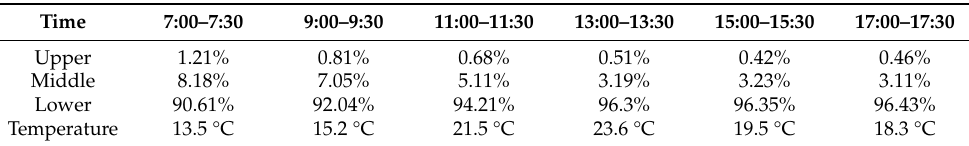
Table 4. Aphid distribution on plants in different time periods.